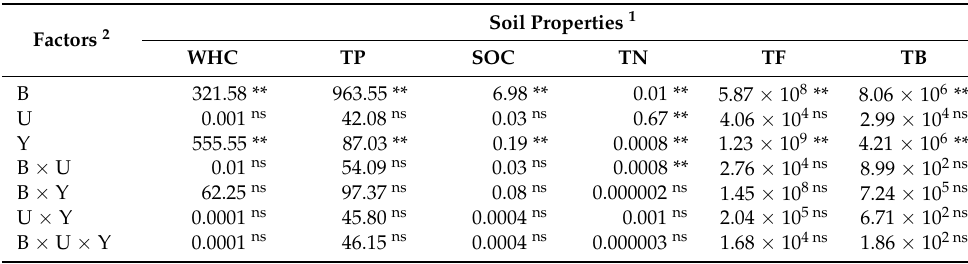
Table 2. Means square of ANOVA in soil properties.